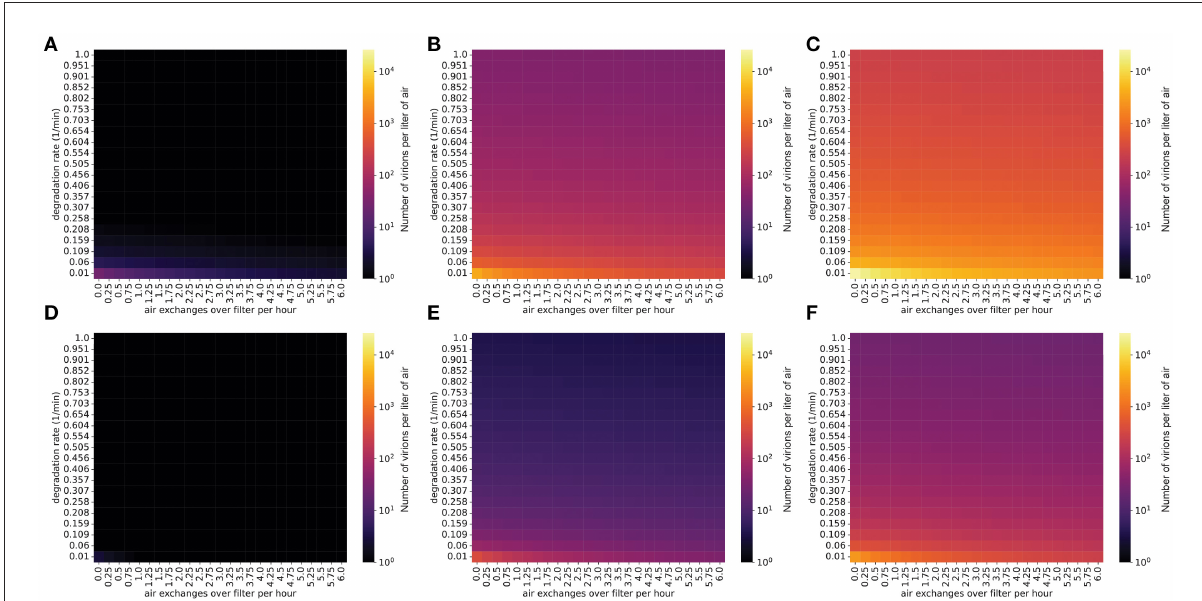
FIGURE3 Steady-state concentrations are decreased by ionizers (which increase the particle degradation rate). Virion concentrations at steady state, in a room with the same dimensions as Figure 1. (A–C) Individual infected with a low viral load, (A) intermediate viral load, (B) or high viral load, (C) strain, no mask. (D–F) Individual infected with a low viral load, (D) intermediate viral load, (E) or high viral load, (F) strain, wearing a 90% effective mask. The degradation rate of airborne SARS-CoV-2 without the use of an ionizer is approximately 0.01/min.